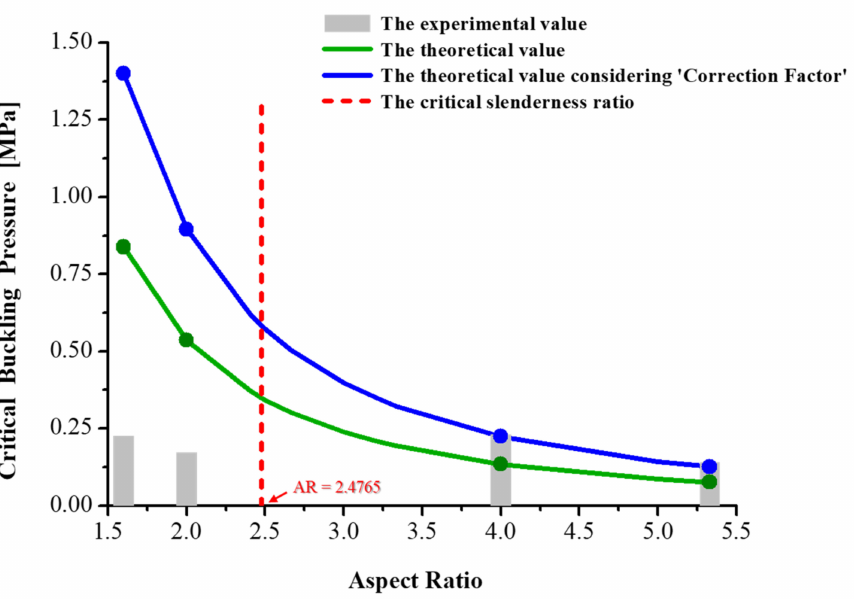
Figure 7. Plot of experimentally obtained and theoretically calculated critical buckling pressures of pillared structures as a function of aspect ratio: (gray bar) is the experimental values, (green line) is the theoretical values, (blue line) is the correction factor calibrated theoretical values, and (red dotted line) indicates the criteria of applicability of Euler’s buckling